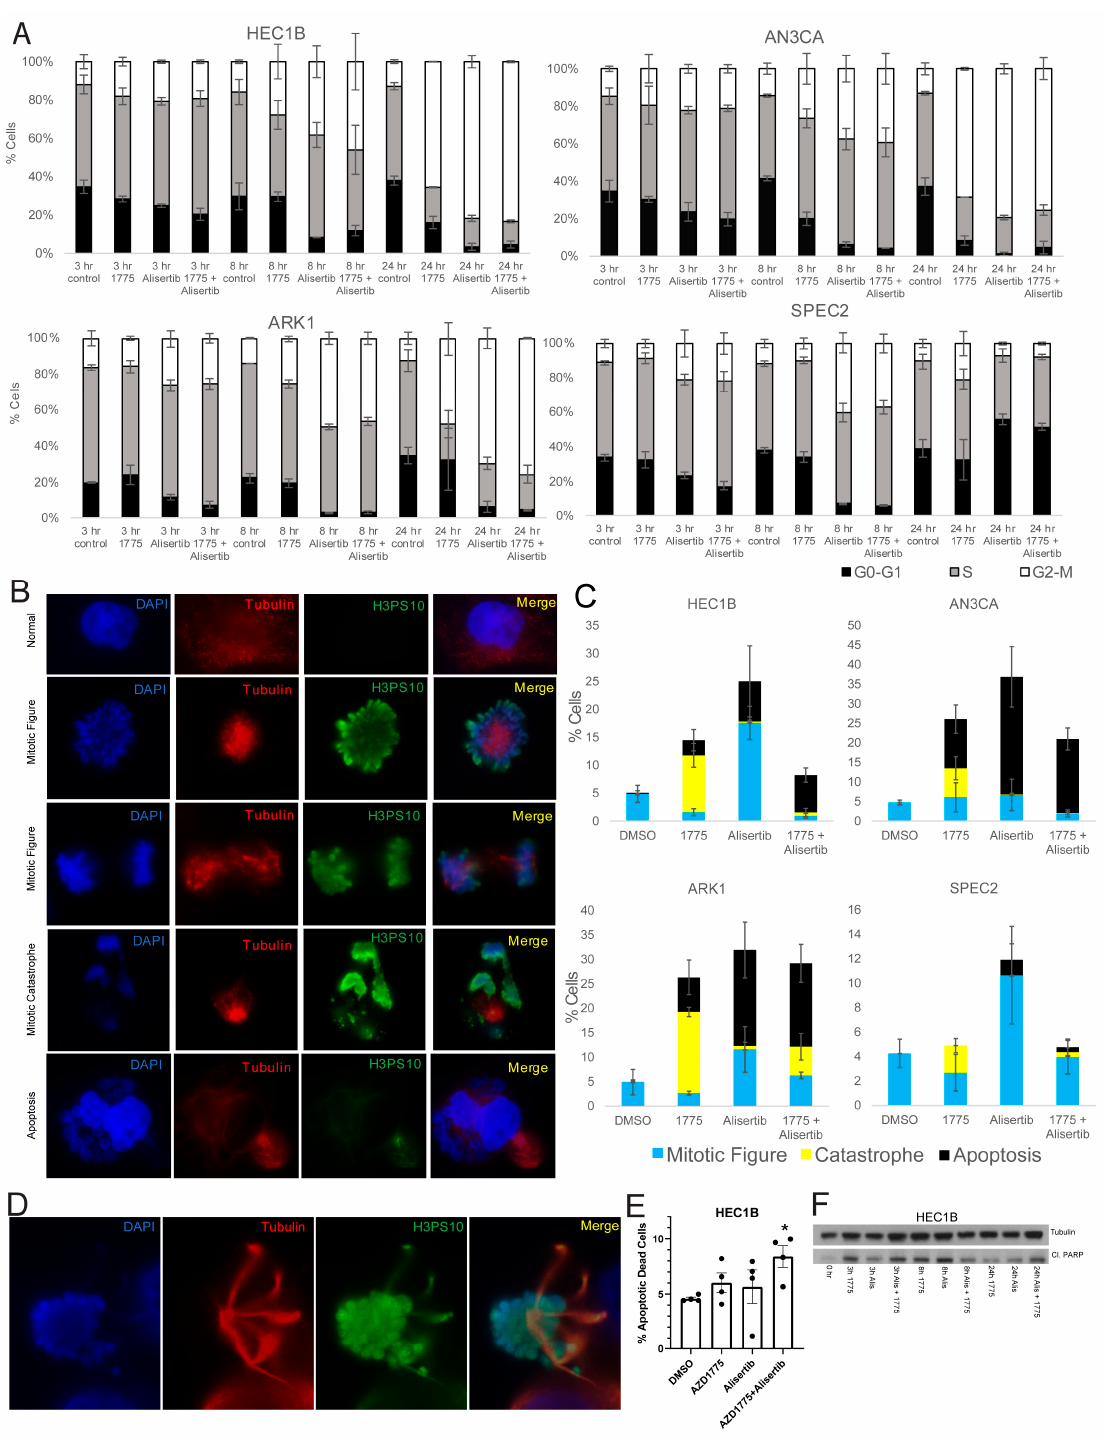
Figure 5. Combining Aurora kinase and WEE1 inhibitors causes increased apoptotic death in Aurora kinase inhibitor resistant cells. ( A ) Cell lines were treated with vehicle (control) or either 0.25 uM Alisertib, 0.5 uM AZD1775 (1775), or